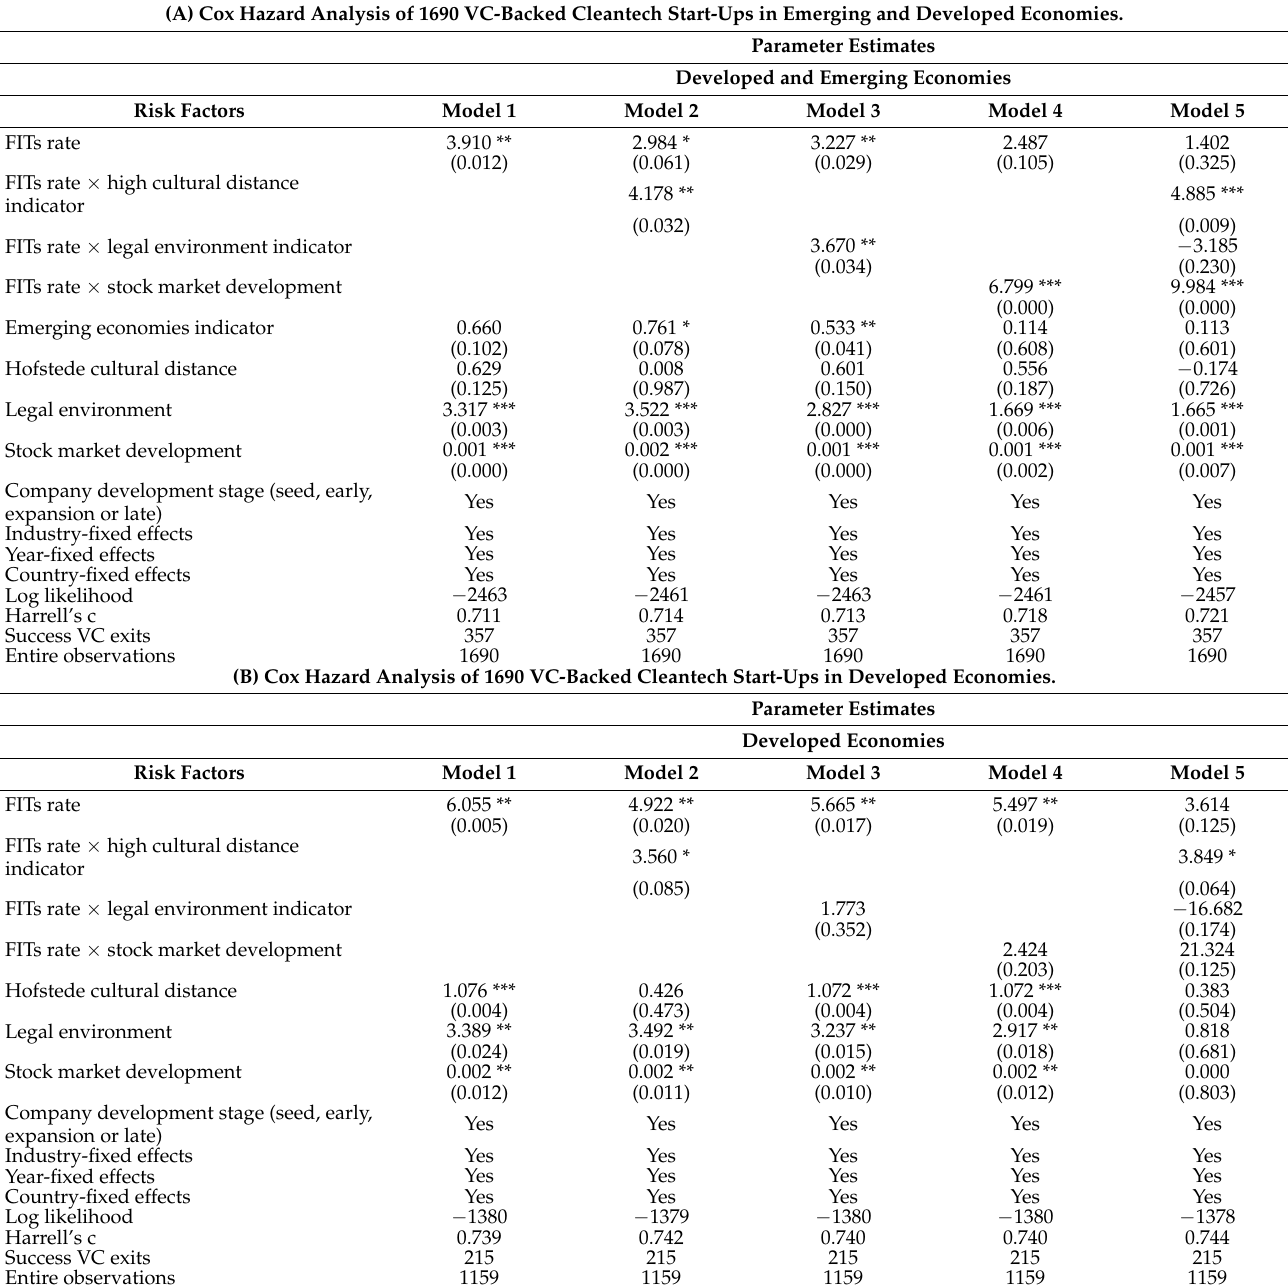
Table 4. Analysis of cleantech start-ups in emerging and developed